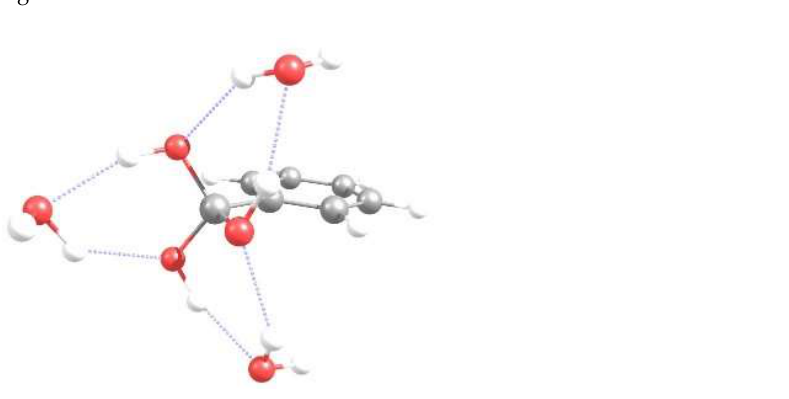
Figure 6. Volumetric ( a ) and gravimetric ( b ) water uptake for the parent and the functionalized Mg-MOF-74-III.